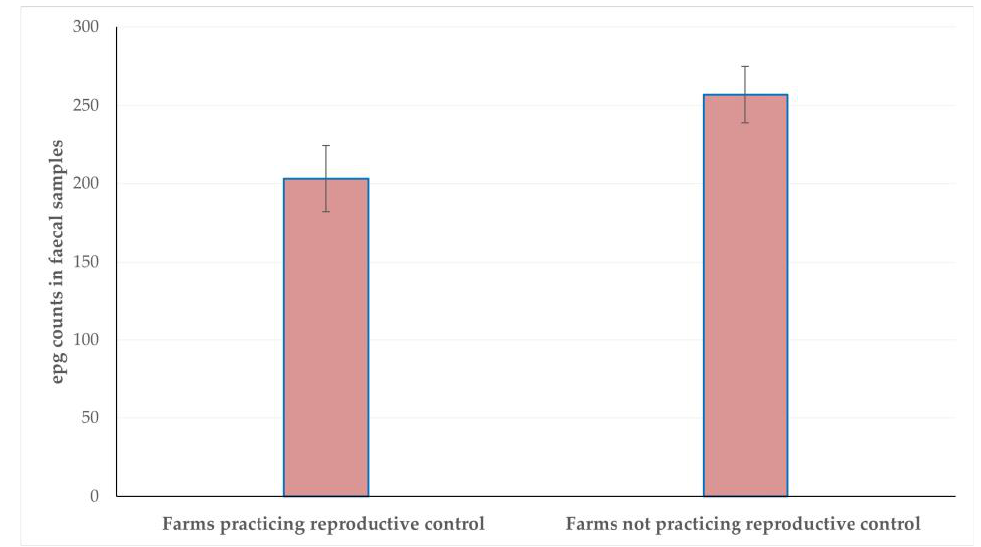
Figure 3. The association of the application of reproductive control practices with epg counts in faecal samples from 279 sheep flocks in a countrywide investigation in Greece. Table 5. The results of the multivariable analysis for a high proportion (>63%) of Teladorsagia spp. among Trichostrongylidae helminths in faecal samples from 279 sheep flocks in a countrywide investigation in Greece.